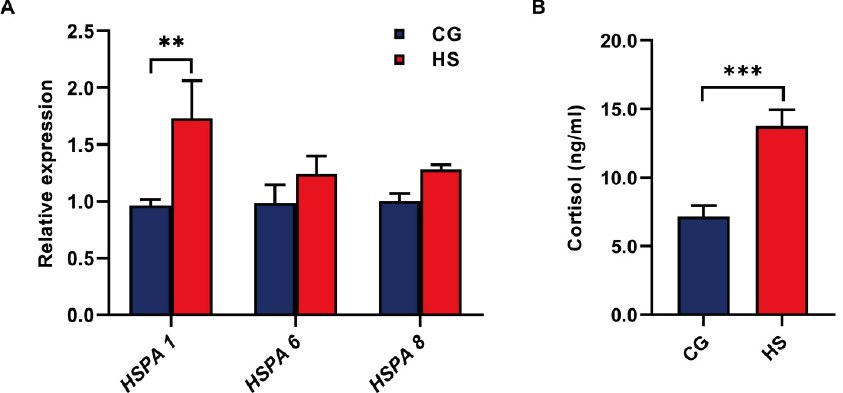
Figure 1. The heat shock protein 70 (Hsp 70) family member gene and serum cortisol concentrations of goats. ( A ) The heat shock protein 70 (Hsp 70) family member gene, including HSPA 1, HSPA 6, and HSPA 8, in the blood lymphocytes of CG and HS. ( B ) The concentrations of serum cortisol of CG and HS. Data were analyzed using a two-tailed Student’s t -test and were considered statistically significant at ** p < 0.01 and *** p < 0.001 between the indicated groups. Data are expressed as the mean ± SEM.